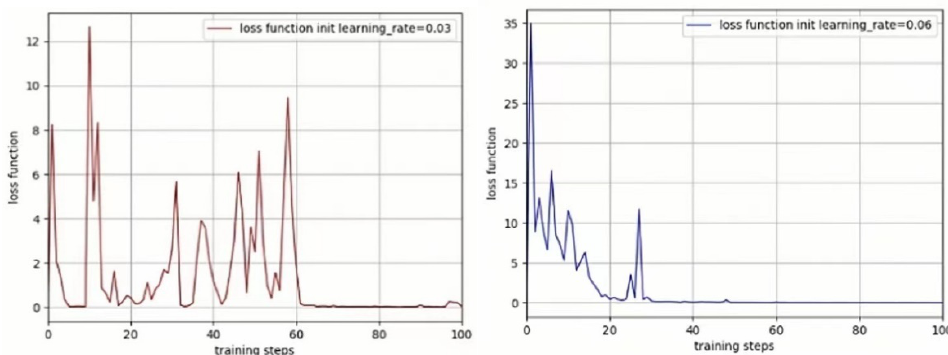
Figure 11. DQN loss function—lr = 0.03 and lr = 0.06.